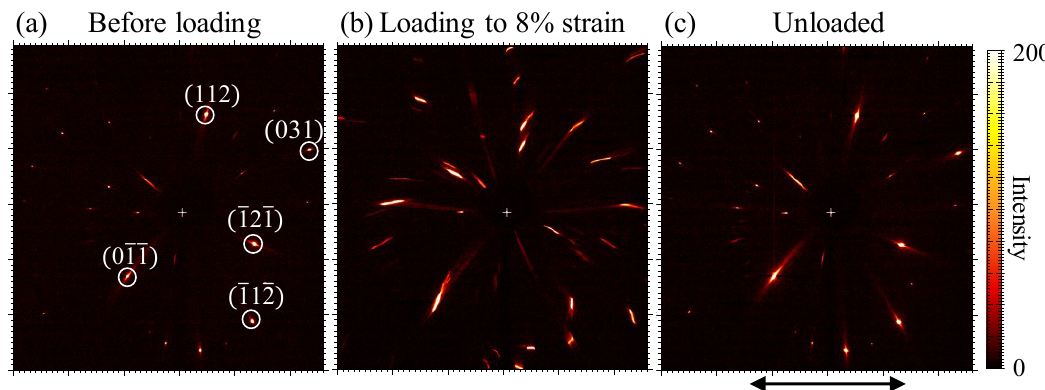
Figure 5. Laue patterns obtained from a point marked by A in Figure 3a ( a ) before loading; ( b ) under a load (8% strain); and ( c ) after unloading. Laue spots were indexed based on their lattice spacing